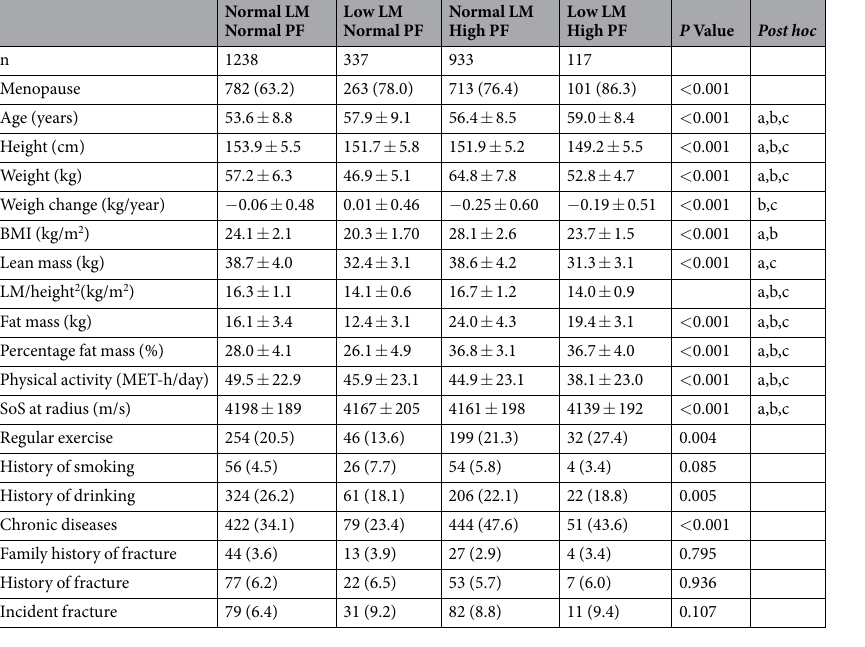
Table 2. Baseline characteristics of women according to body composition (n = 2,625). Values are means ± SD